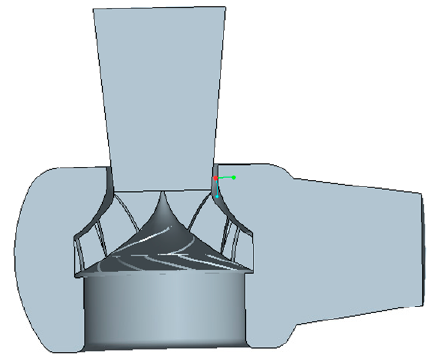
Figure 1. Three-dimensional fluid calculation domain of reactor coolant pump.